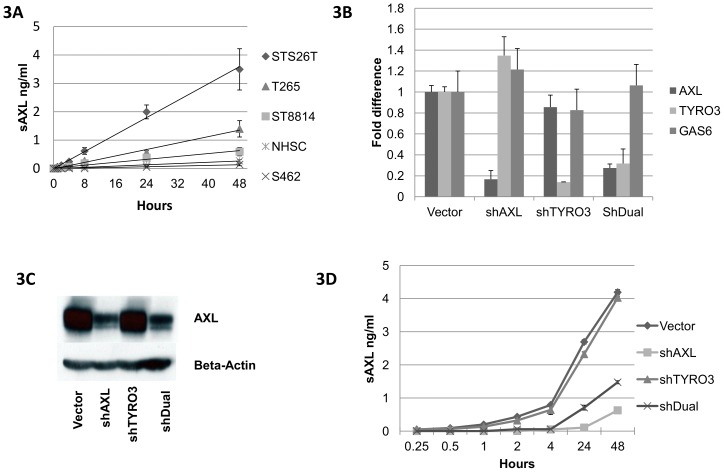
Release of sAXL into the conditioned media of MPNST cell lines.
A, all four MPNST cell lines (S462, STS26T, ST8814 and T265) and NHSC released sAXL into the conditioned media, at levels that roughly comparable to the protein levels of full length AXL in the cells (Fig. 2A). A highly-matched correlation was found between the time in culture and the sAXL concentration in all four cell lines and NHSC (symbol cross for S462 cells with a coefficient of determination, R2 = 0.97; diamonds for STS26T with R2 = 0.99, squares for ST8814 with R2 = 0.97, triangles for T265 with R2 = 0.99 and star for NHSC R2 = 0.94). To further highlight that all cell lines release sAXL at a constant rate, the data in Fig. 3A is presented as 5 individual graphs in S1 Fig. B–C
, Using specific lentiviral shRNA clones, the expression of AXL and TYRO3 has been knocked down in MPNST cell line T265, either alone or in combination to knockdown both genes (shDual). Successful silencing was verified with quantitative-PCR (Fig. 3B) and Western blotting (Fig. 3C). D, the levels of sAXL in the cell medium were drastically reduced in AXL-knockdown cells. In contrast, knockdown of TYRO3 did not affected the release of sAXL compared to the empty vector (GIPZ). In each case the level of sAXL in the conditioned media corresponded to the mRNA levels in the cells.